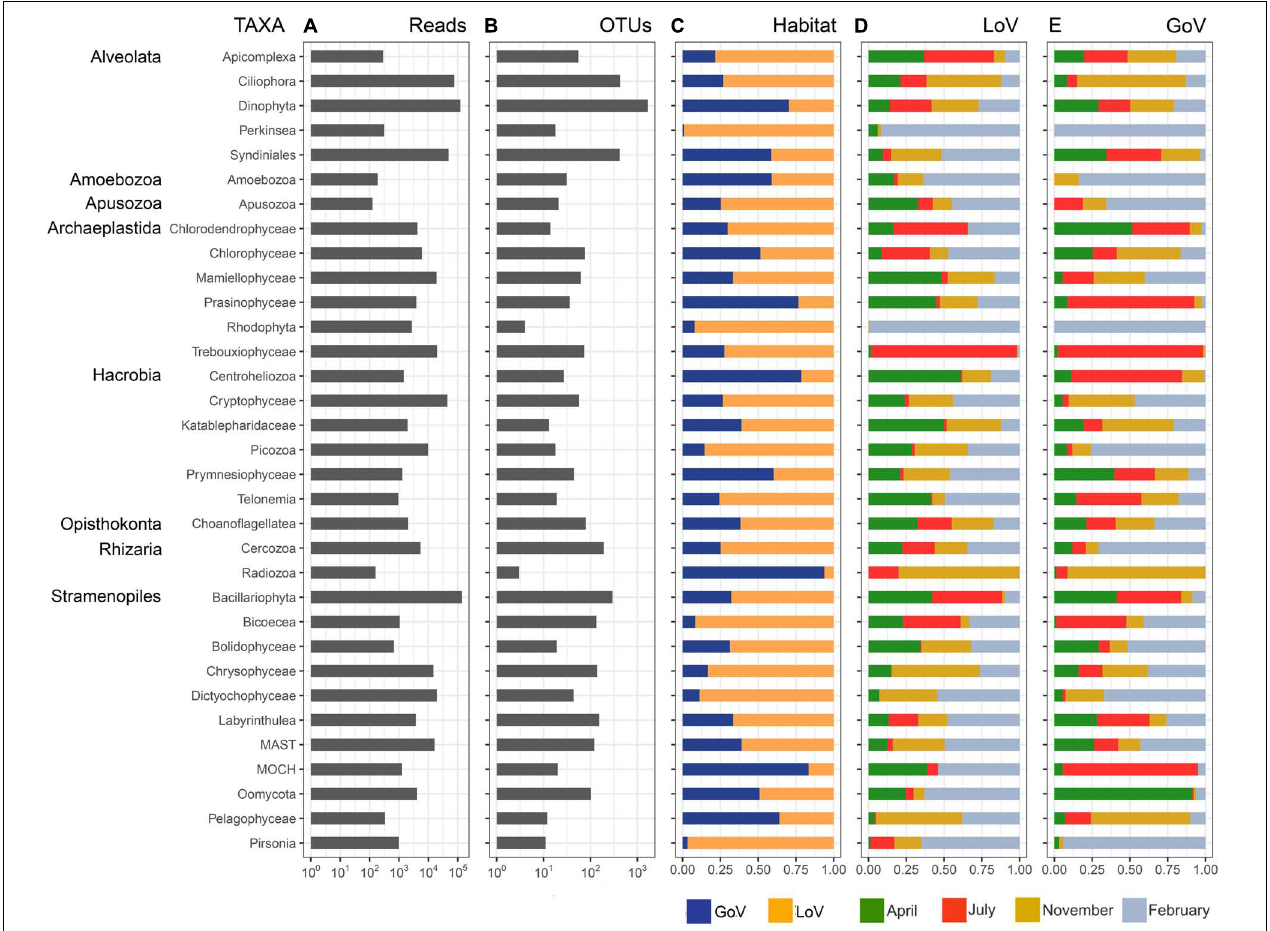
FIGURE 2 | Taxonomic group composition based on the normalized dataset: (A) number of reads; (B) number of OTUs; (C) relative abundance of reads in the two habitats; (D) relative abundance of reads in the months sampled in the Lagoon (LoV), and (E) in the Gulf of Venice (GoV). MAST, Marine Stramenopiles; MOCH, Marine